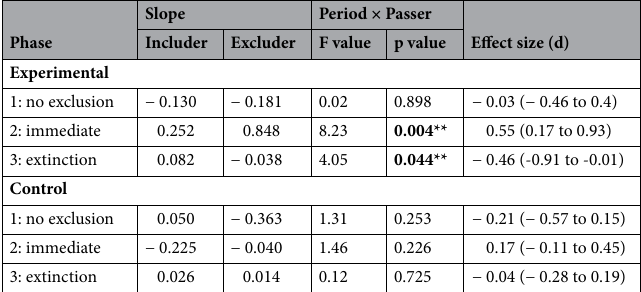
Table 3. Piecewise regression results for return vs. no return passing.